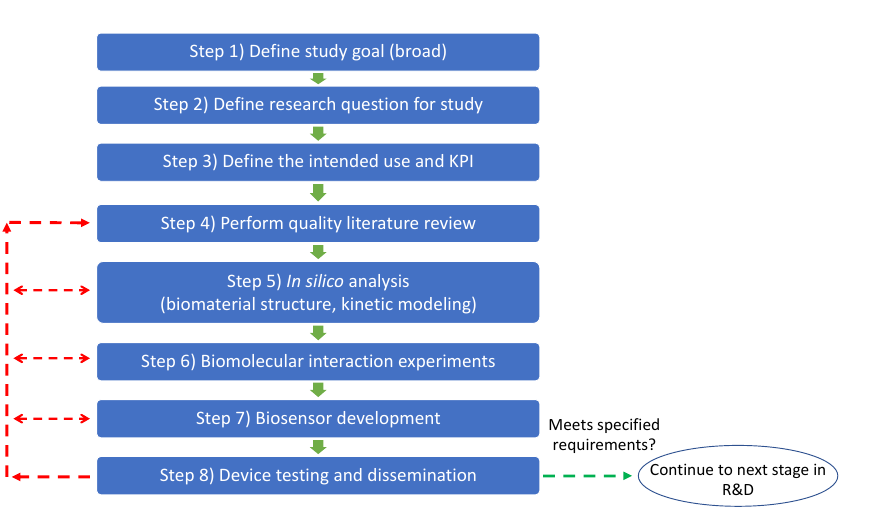
Figure 7. Flowchart for applying framework. Experimental design and iteration in steps 5–7 should always consider the study goal, intended use, and research question of the study as a guide for decision-making. This process also facilitates updating the quality literature review (use of PRISMA framework is highly suggested). Green arrows indicate that the prototype meets the requirements, and we can move to the next process step. Red arrows indicate that the prototype does not meet the specified requirements and an iteration to prior step(s) is required.